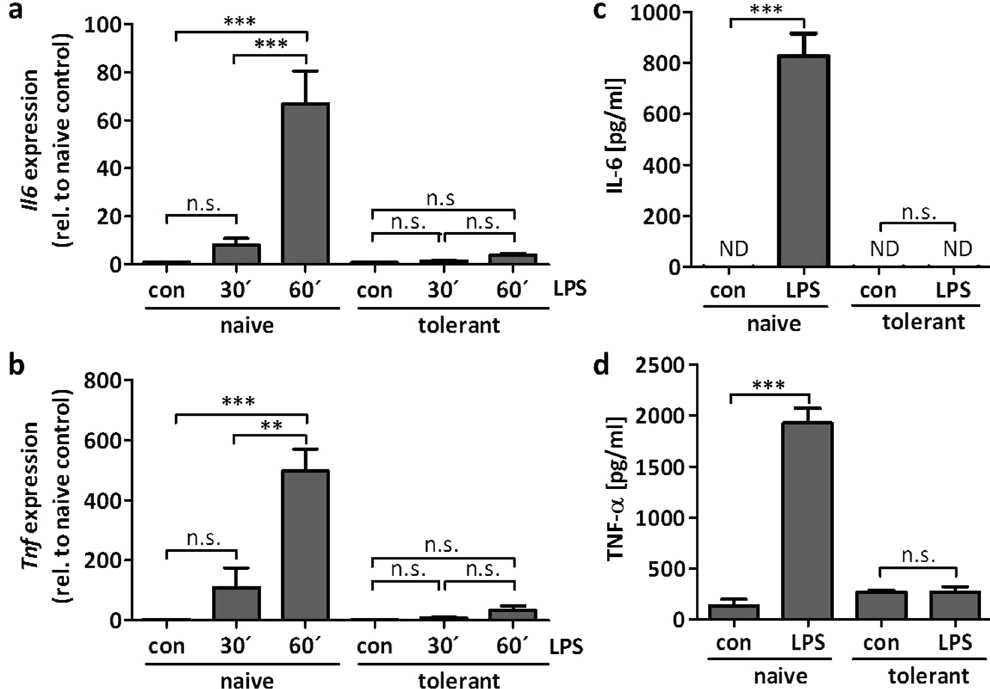
Figure 1. Murine BMMCs can develop ET. BMMCs were pretreated with LPS (300 ng/ml) for 24 h to induce ET. For analysis of the cytokine expression, the cells were stimulated with LPS (1 µ g/ml) for 30 min and 60 min and the gene expression of Il6 ( a ) and Tnf ( b ) was measured. Data show mean ± SD from n = 3 independent experiments. Two-sided ANOVA with Tukey HSD post-hoc test and one-sample t -Test were performed to calculate the p-values. Multiple testing p-values were corrected by FDR. Furthermore, LPS-pretreated and naive cells were stimulated with LPS (1 µ g/ml) for 4 h to analyse protein production of IL-6 ( c ) and TNF- α ( d ). Data show mean ± SD from three independent experiments. Student’s t -Test was performed to calculate the p-values. ** p < 0.01, *** p <